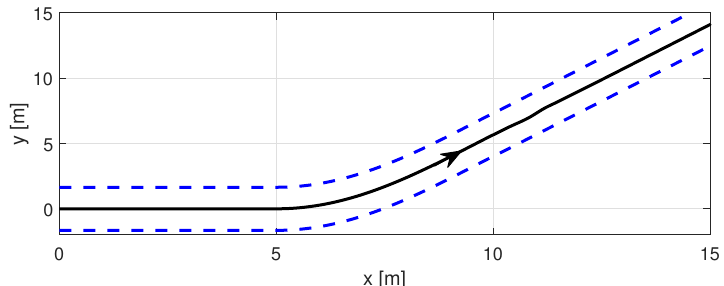
Figure 15. Vehicle trajectory of the proposed